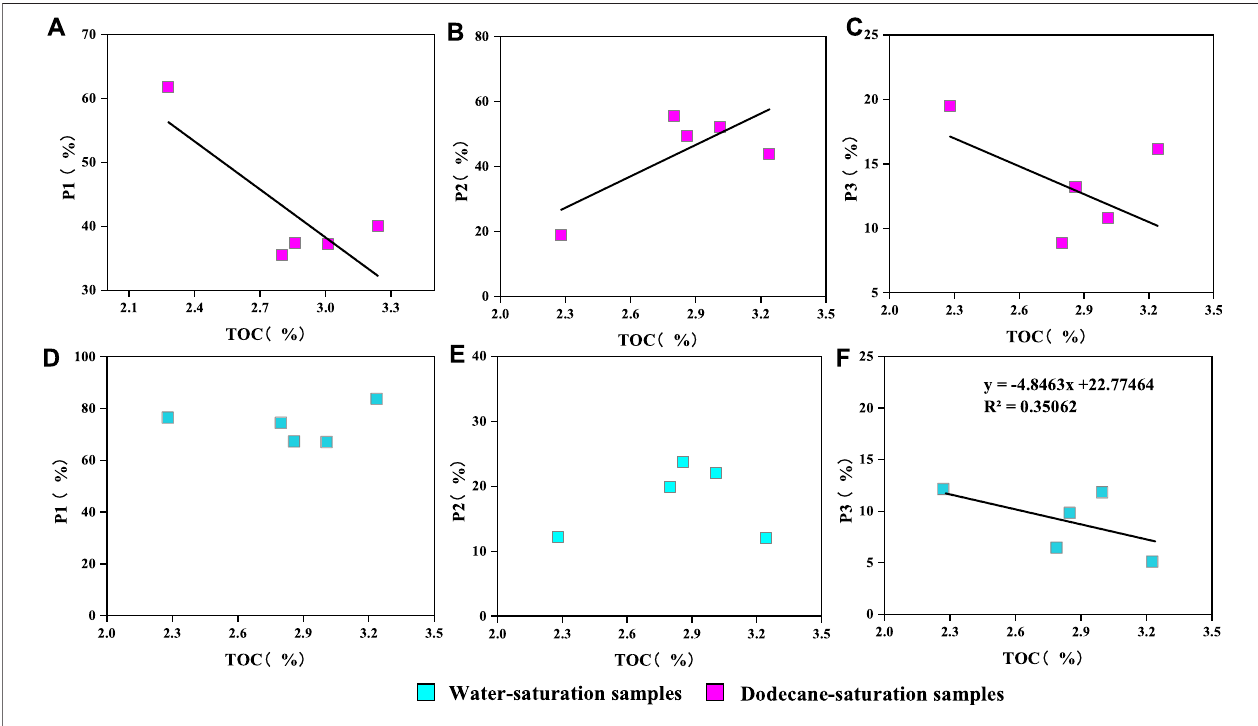
FIGURE 12 | A relationship between TOC and proportion of three peaks for (A – C) dodecane-and (D – F) DIW-saturated samples.